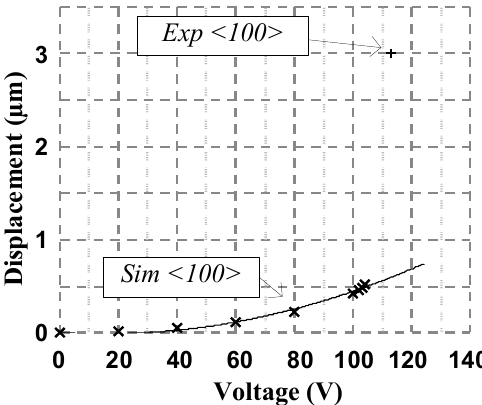
Figure 12. Simulation and experimental gap closer displacement vs the actuation voltage for <100>